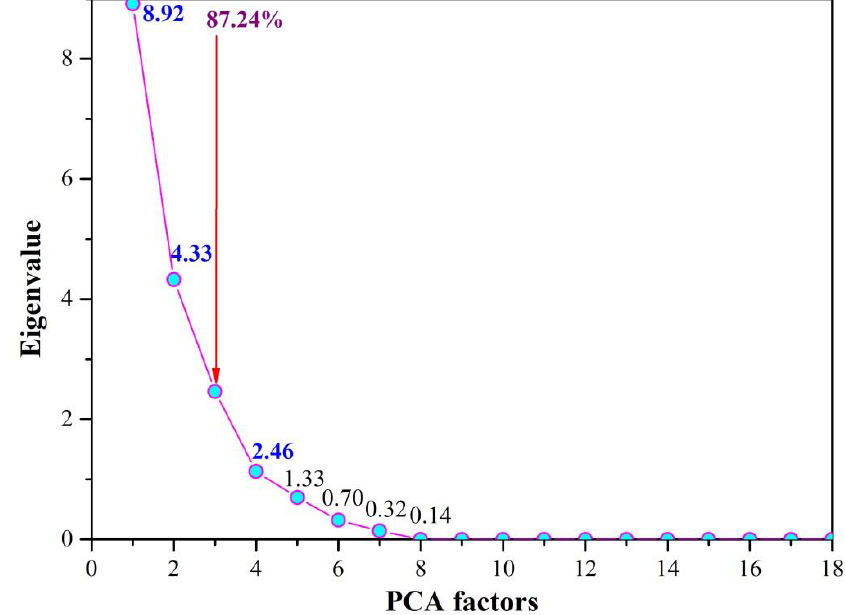
Figure 2. The scree plot. Table 2. Loads of 18 variables in three principal components.